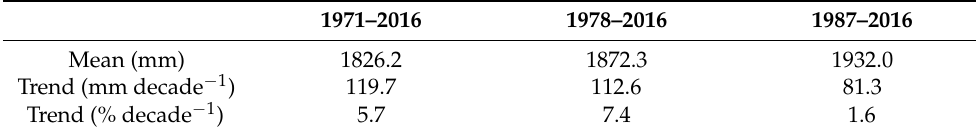
Table 2. Mean and trends of ETr across different time periods over the Mun River